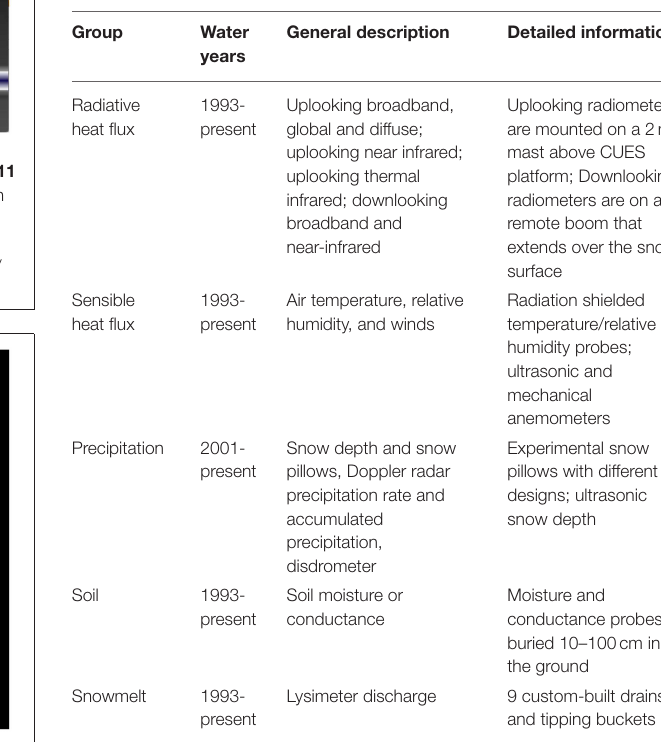
TABLE 1 | Summary of long term measurements at